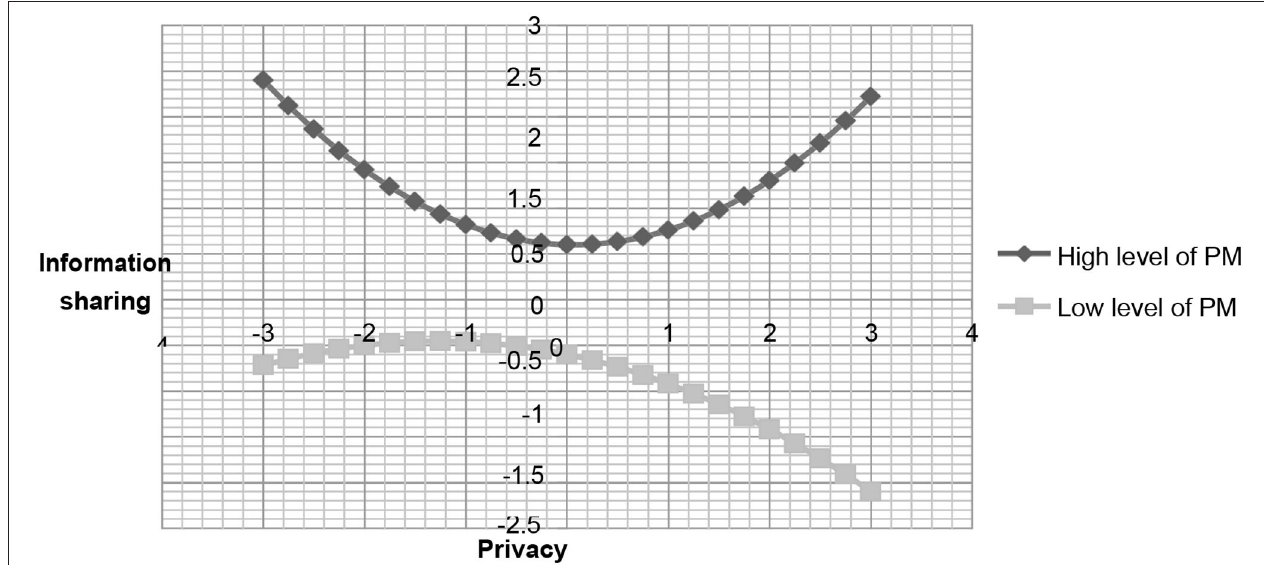
FIGURE 3 | The relationship between privacy concern and information sharing under different level of personal